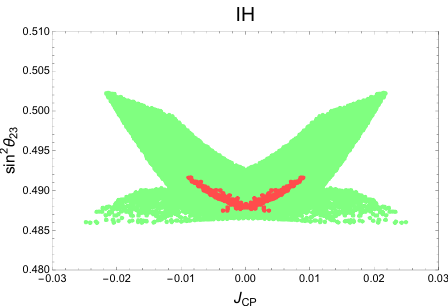
Figure 2 . Predicted CP violation versus atmospheric angle for IH. Green (Red) regions correspond to 3 (1) (cid:27) values for the solar and reactor angles in eqs. (5.18), (5.19). All predicted values for sin 2 (cid:18) 23 in this case lie into its 2 (cid:27) region